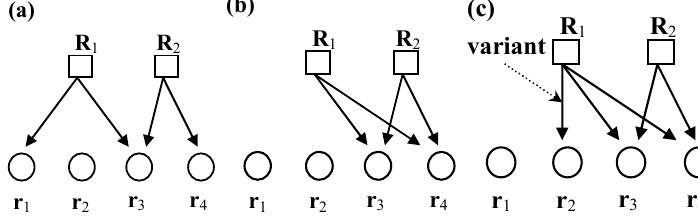
Figure 5. Evolutionary learning at the MM neural level. ( a ) Low-level MM neurons controlled by each high-level MM neuron are activated in sequence for evaluating their performance. Assume the MM neurons controlled by R2 achieve better